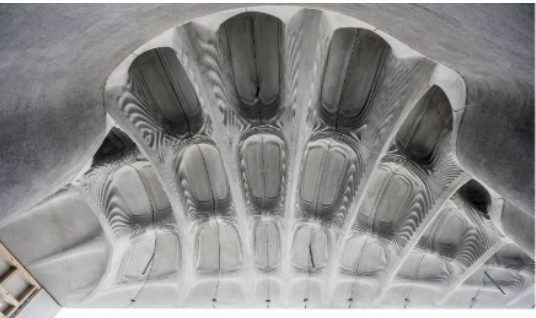
Figure 5. Concrete part formed on a Binder-Jetted tool [38].